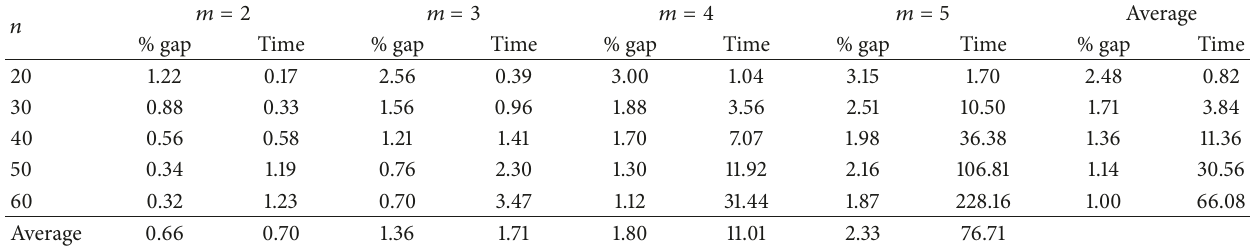
Table 2: Results of average percentage gap for the first MP solution using instances from Vallada and Ruiz (2011).